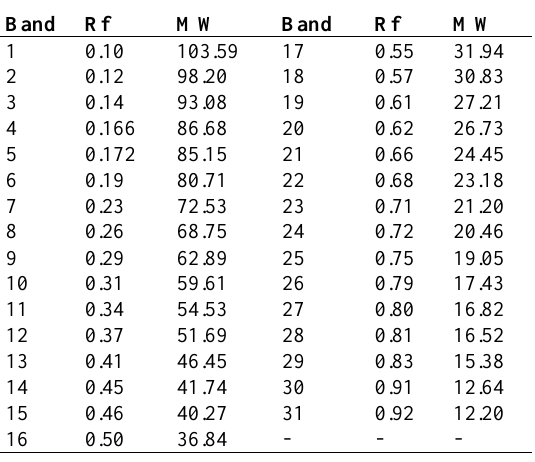
Table 2. Number, relative mobility and molecular weight of observed bands